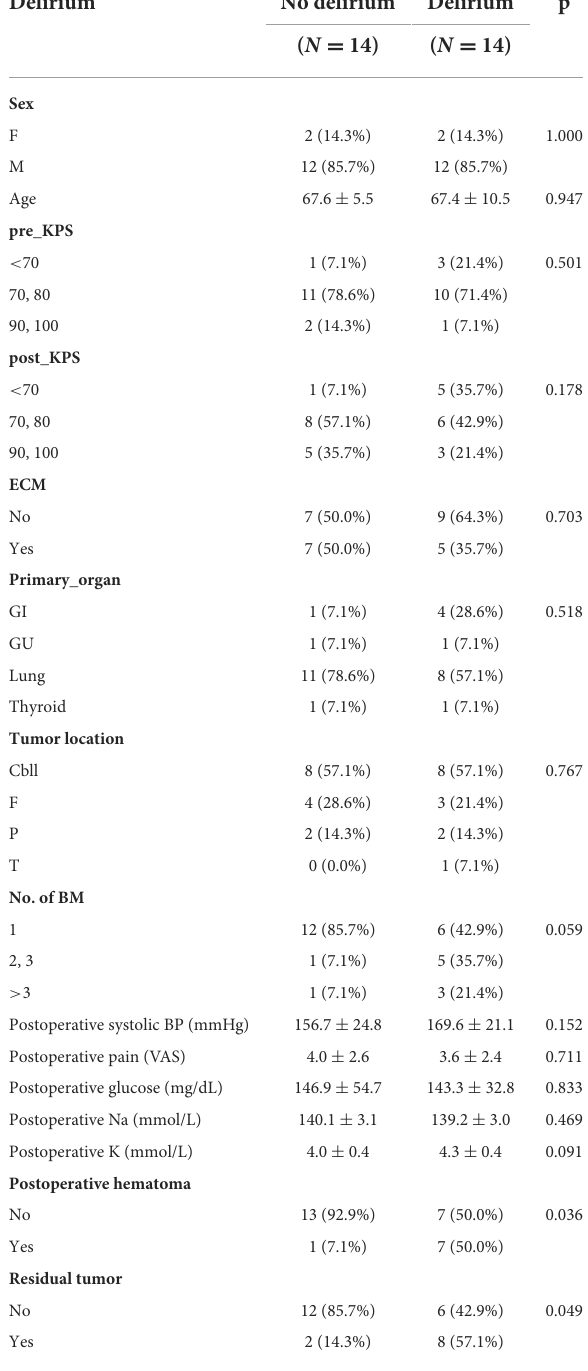
TABLE 2 Propensity score matching (age, sex, primary cancer, tumor